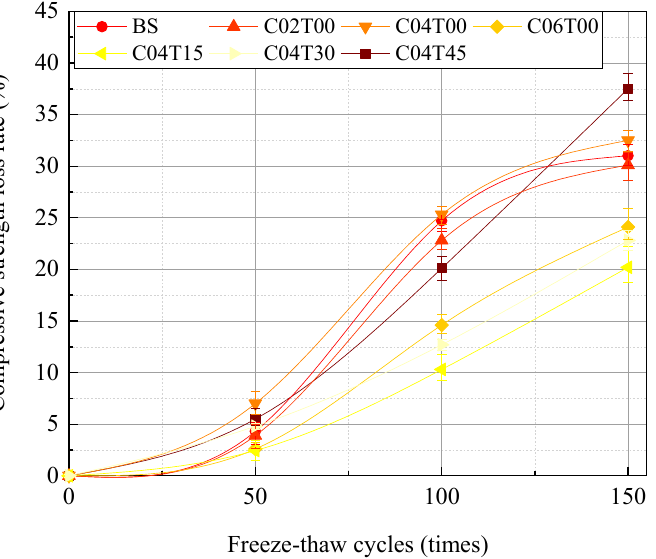
Figure 7. Compressive strength loss rate of cement-based composites under freeze-thaw cycles.